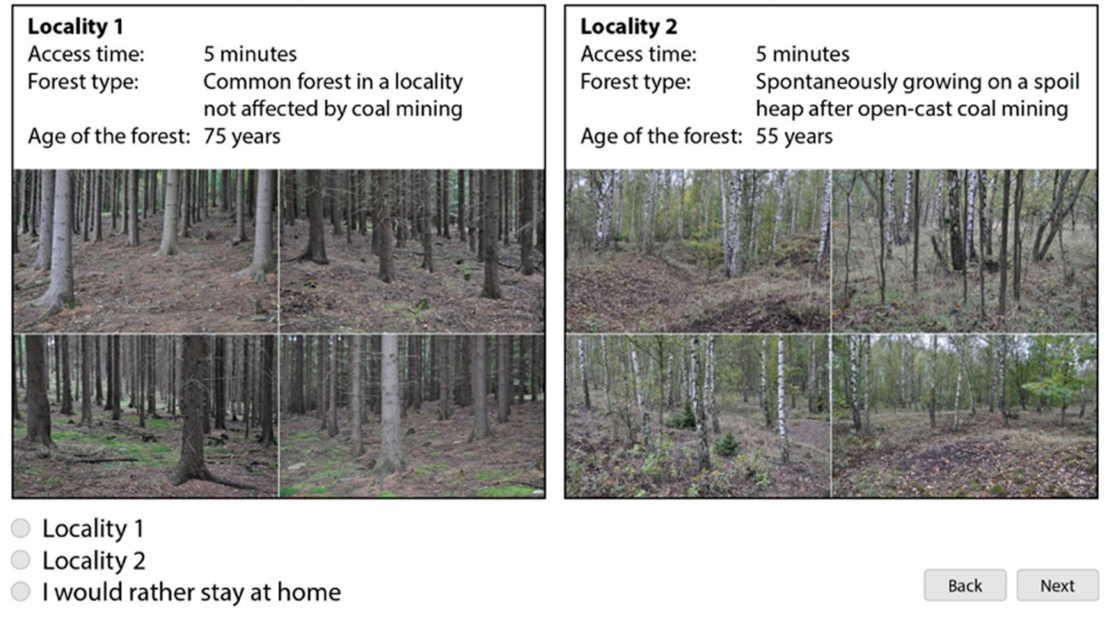
Figure 3. Example of choice experiment